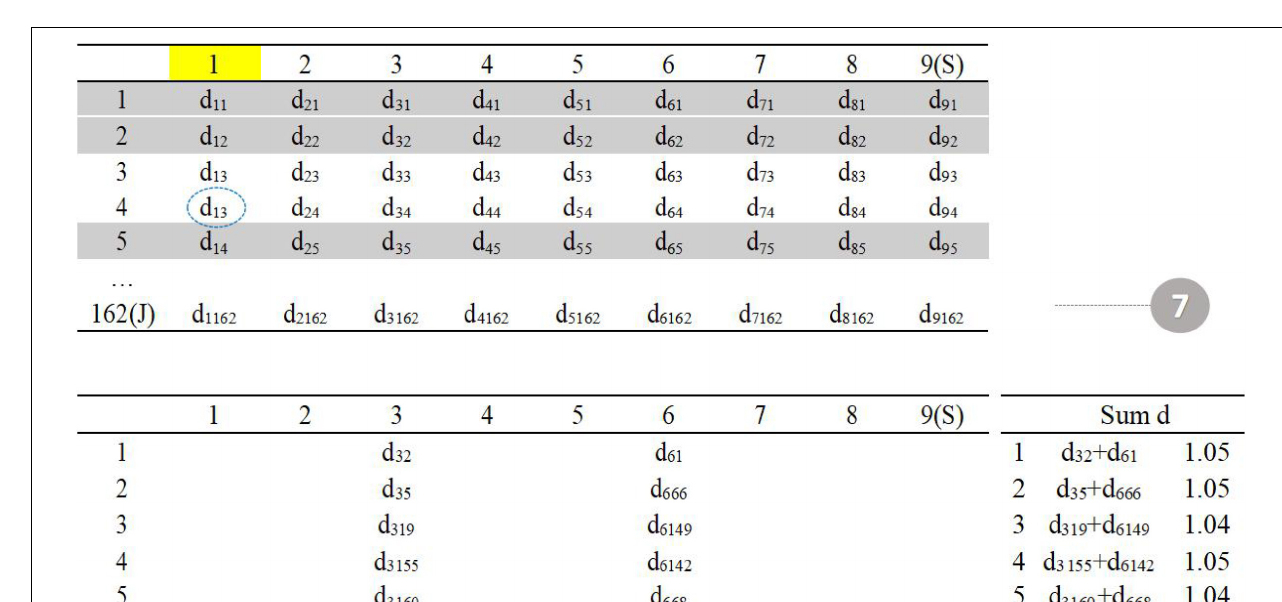
FIGURE 5 | Procedure